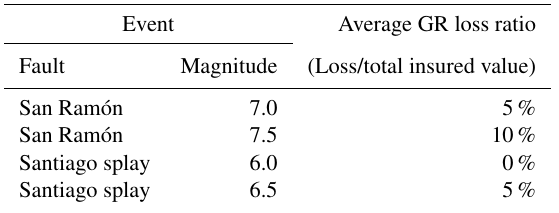
Table 3. Gross loss (GR) ratios for the Santiago non-residential ex- posure.